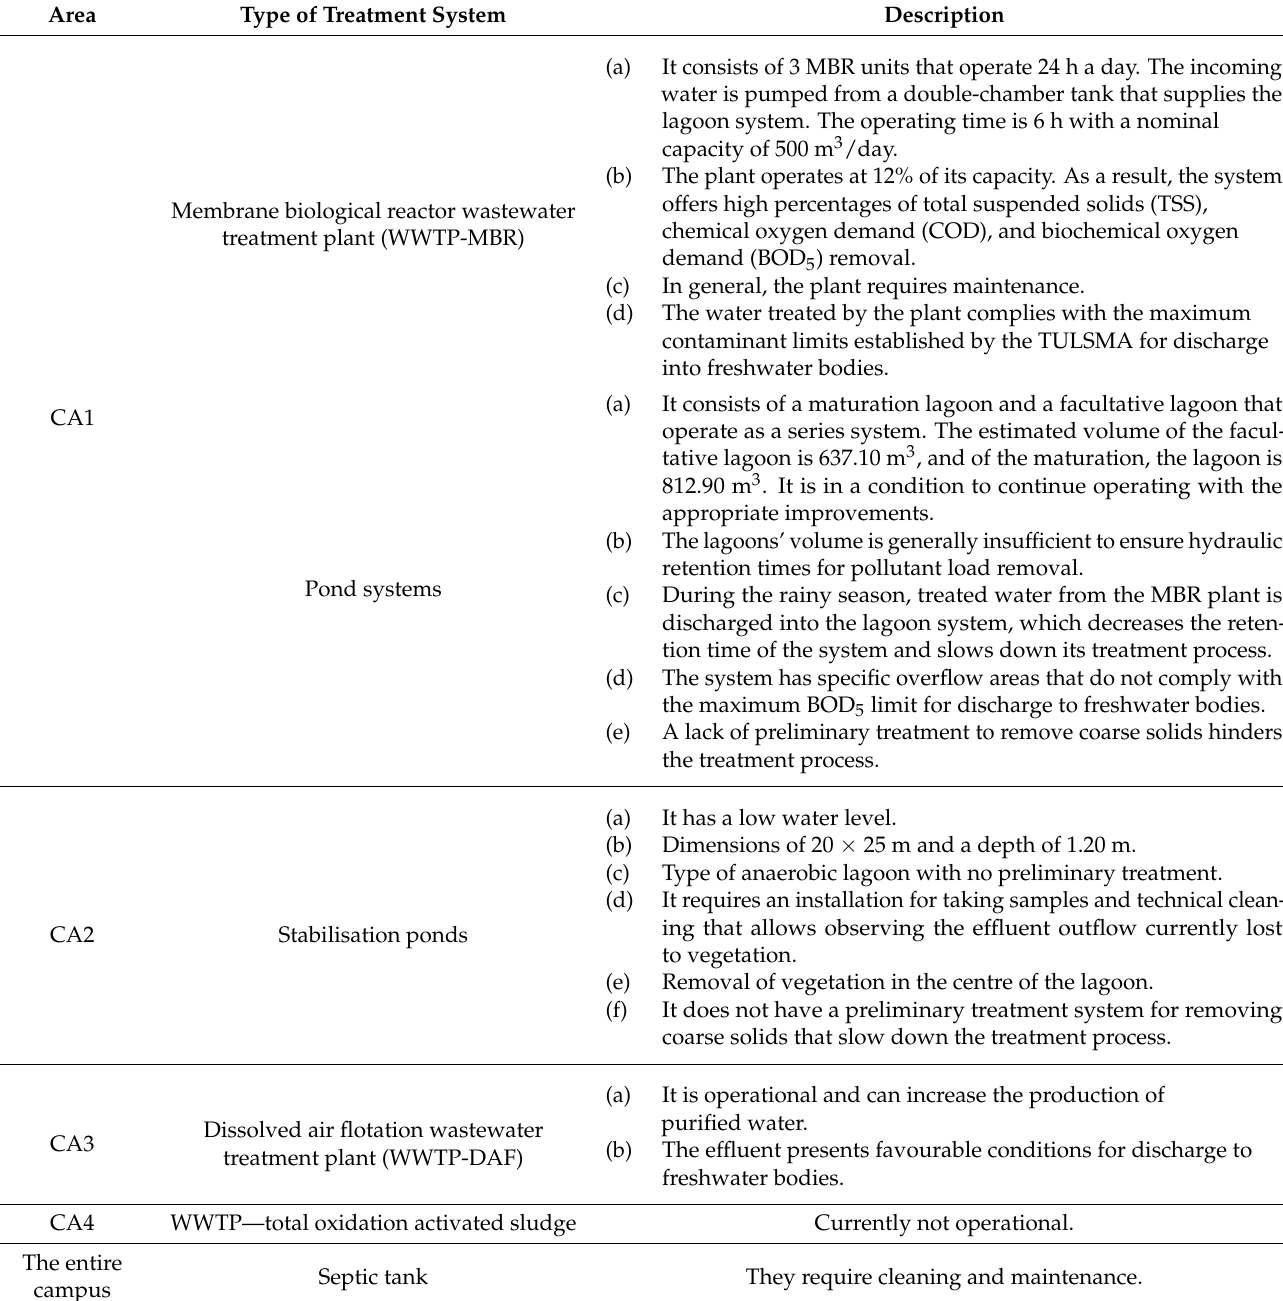
Table 2. Description of existing scrubber systems.